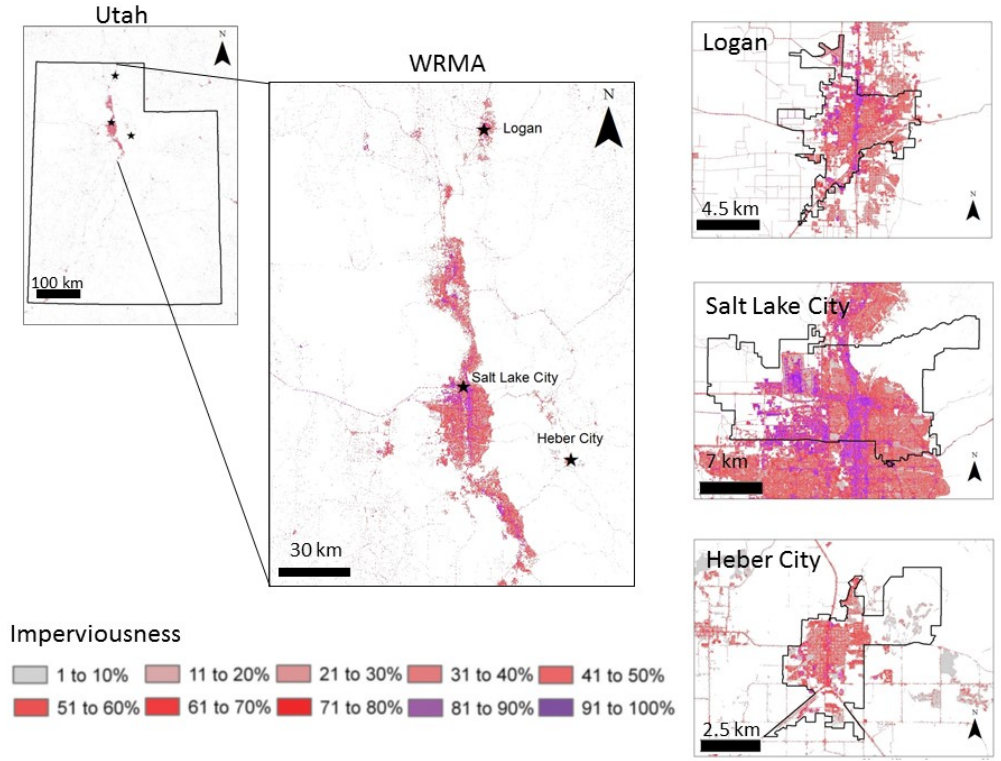
Figure 1. Location and imperviousness of three study cities. Imperviousness data from 2011 National Land Cover Database [30].